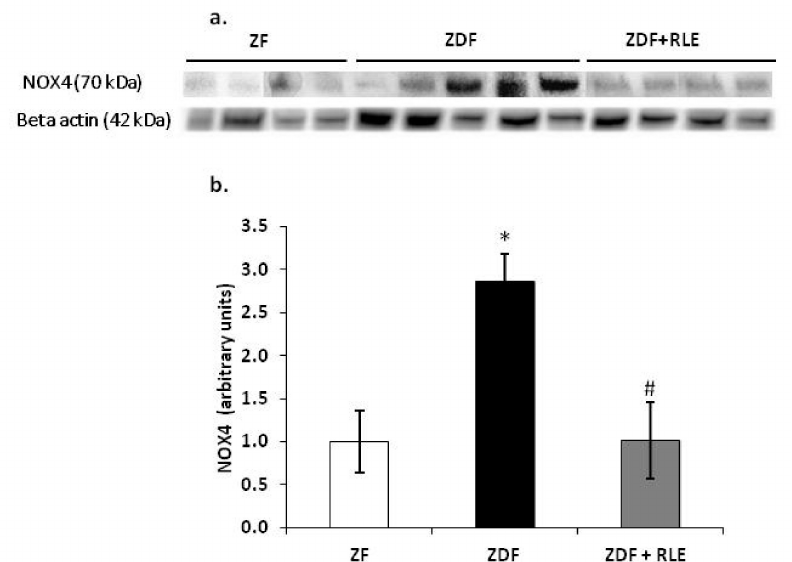
Figure 3. E ff ect of red orange and lemon extract (RLE) on the protein levels of the NOX4 in the Zucker Fatty (ZF) ( n = 4), Zucker Diabetic Fatty ZDF ( n = 5), and Zucker Diabetic Fatty + red orange and lemon extract (ZDF + RLE) ( n = 4), after 24 weeks of treatment. ( a ) Representative western blot of NOX4 in ZF, ZDF, and ZDF-treated group. ( b ) The panel represents the densitometric analysis of NOX4. The experiments were conducted in triplicates, and the values were normalized towards actin. Densitometric analyses are expressed as arbitrary units. Data are shown as mean ± standard deviation (DS) and compared by ANOVA (* p < 0.05 versus ZF. # p < 0.05 versus ZDF).